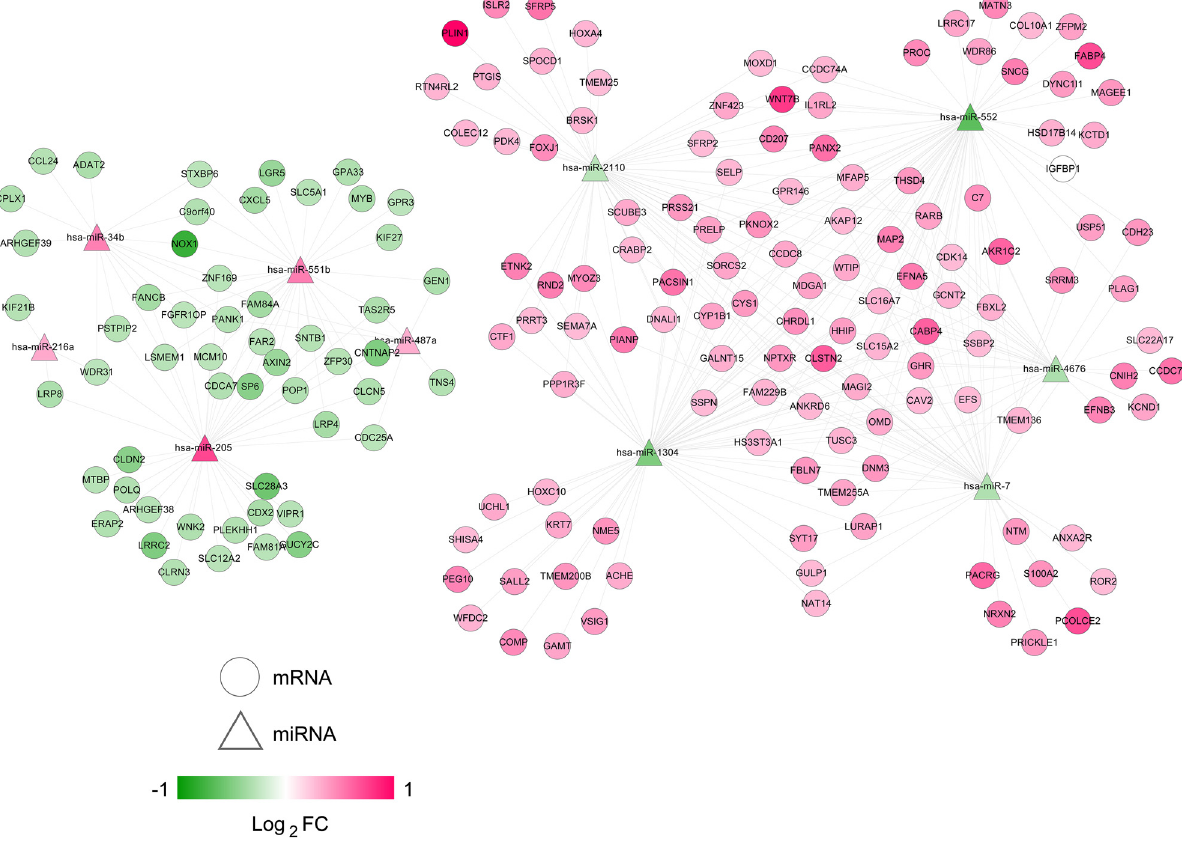
Figure 7: The miRNA – mRNA network. Balls and triangles denote mRNAs and miRNAs,